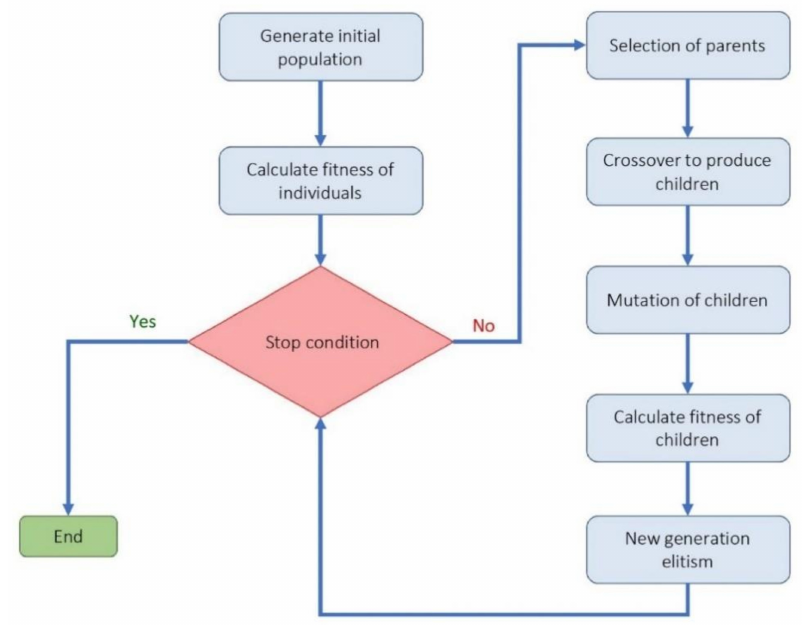
Figure 3. Steps involved in development of genetic optimization